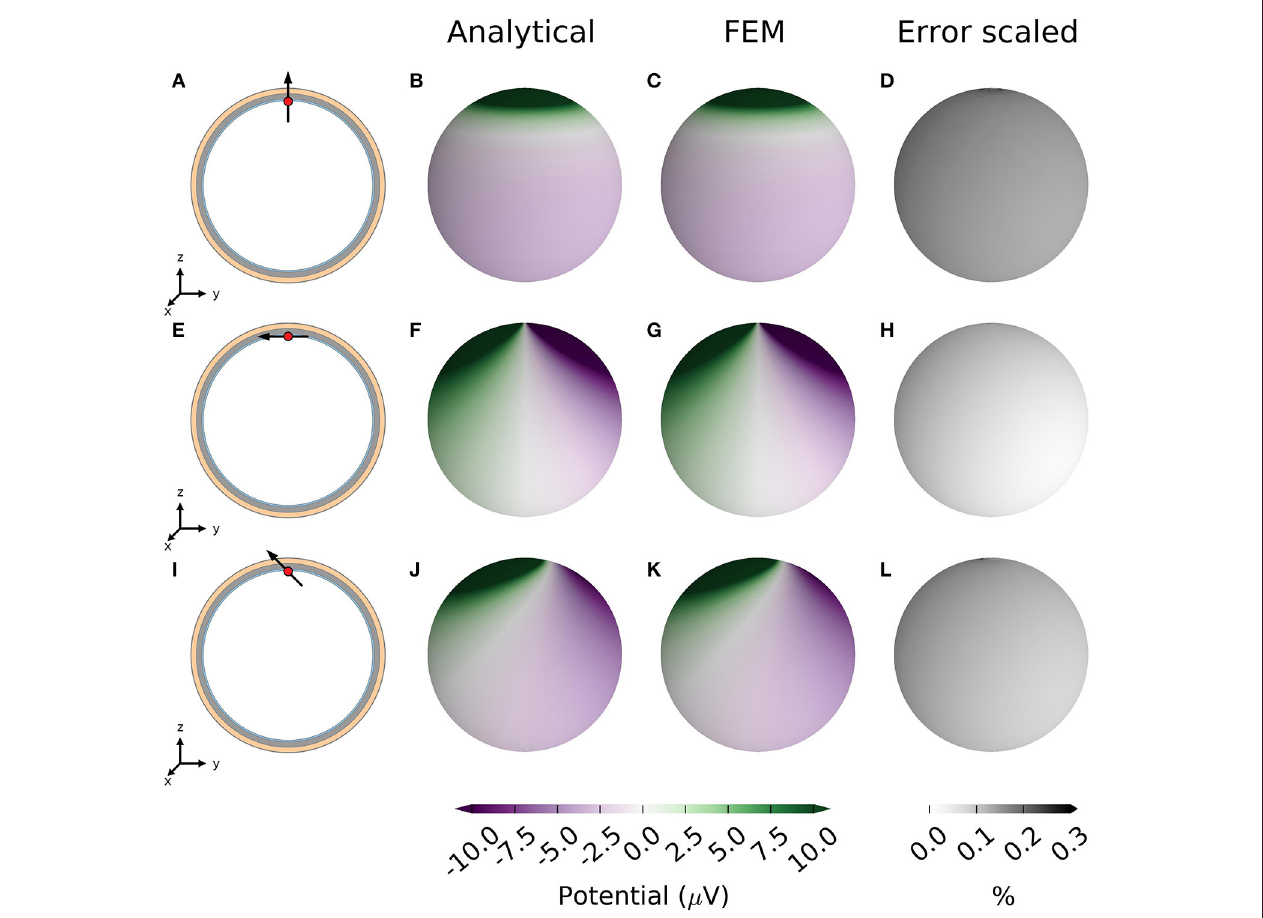
FIGURE 2 | EEG potentials computed with four-sphere model and FEM simulation for radial, tangential, and 45-degree dipole. (A) A radial current dipole placed in the brain in the head model as described in Table 1 . The dipole (black arrow) is located at r z = [0,0,7.8 cm] (red dot) and has a magnitude 10 − 7 Am to give scalp potentials some tens of microvolts in magnitude, typical for recorded EEG signals. (B) Resulting scalp potential calculated with the analytical four-sphere model. (C) Scalp potential computed with FEM. (D) Absolute difference between results from analytical calculation and FEM, normalized by the global maximum of the magnitude of the potential. The second row, panels (E–H) are equivalent to the top row, however for a tangential dipole parallel to the y -axis, in the x = 0 plane. The bottom row, panels (I–L) are equivalent to the top row, however for a dipole that subtends 45 degrees to the z -axis in the x = 0